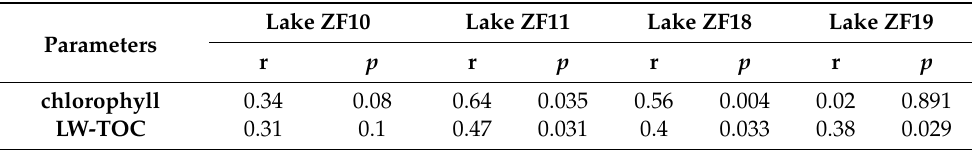
Table 3. Temporal correlations between the community structure and inferred LW-TOC and sediment chlorophyll concentrations for each